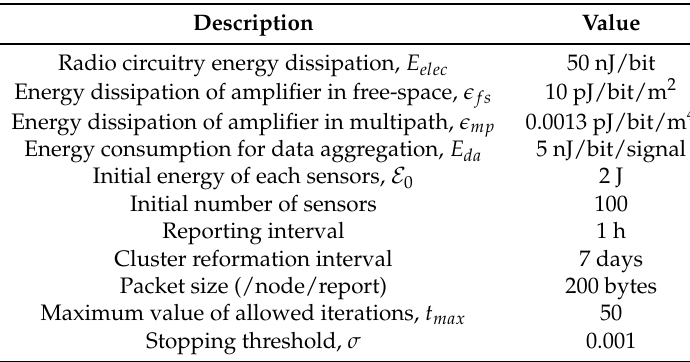
Table 1. Simulation Parameters.